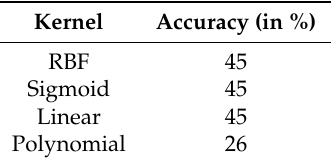
Table 2. Accuracy of model classifier with different kernels.